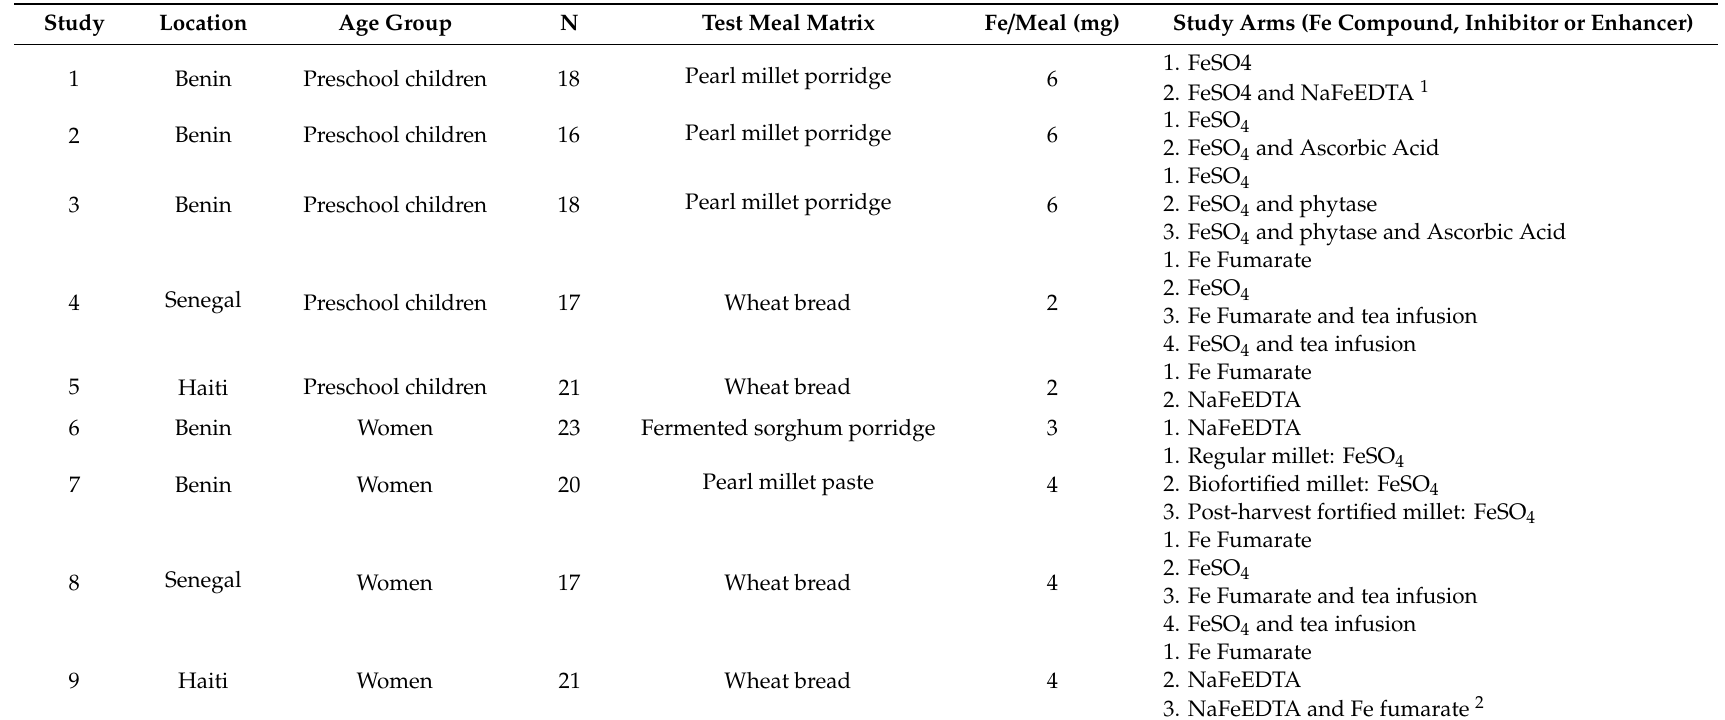
Table 1. Overview of the studies included in this analysis: Study population, sample size, test meals and iron compounds